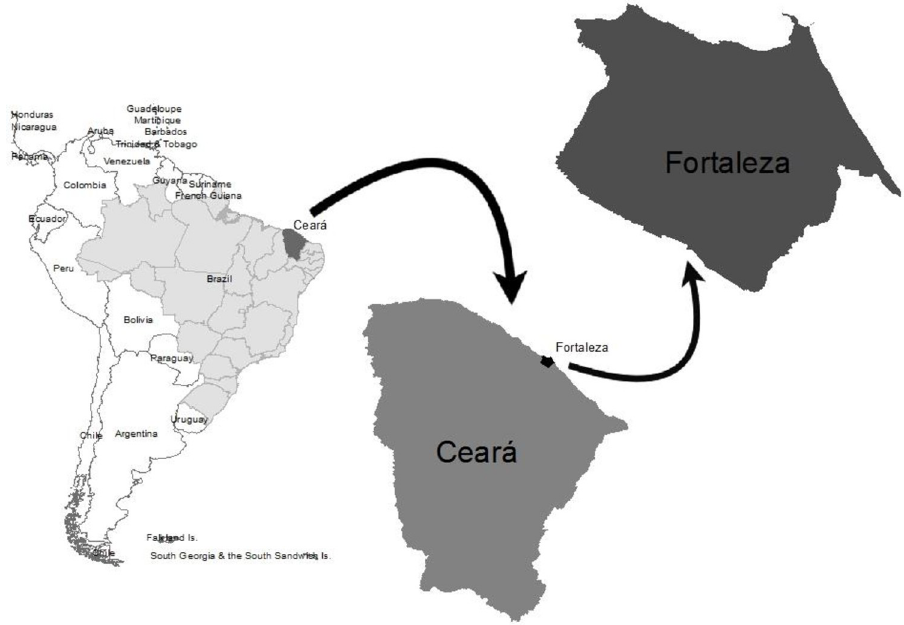
Fig 1. City of Fortaleza, Ceara´,